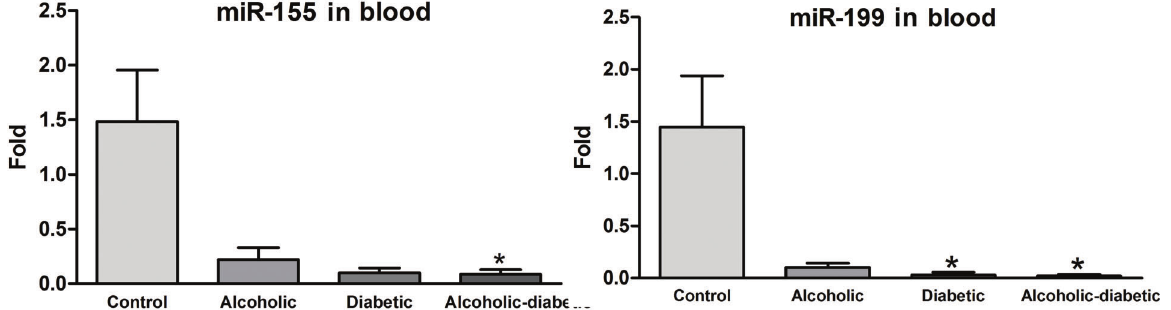
Figure 5. Mean ( ± standard error) of microRNA-155 and -199 expression in blood samples of the groups studied. *P o 0.05, compared to the control group (Kruskal-Wallis test, Dunn ’ s